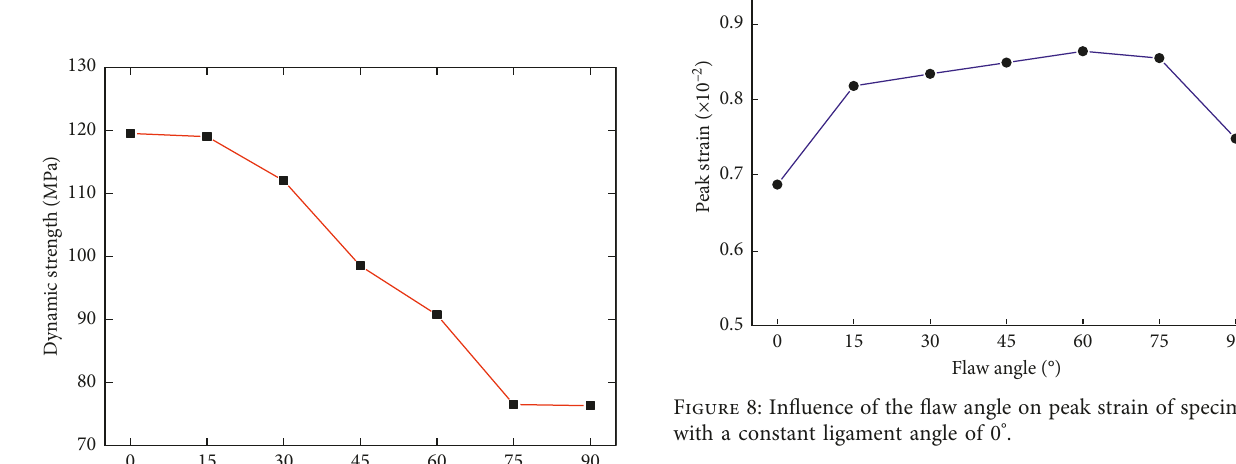
Figure 5: Influence of the flaw angle on the dynamic stress-strain curves of specimens with a constant ligament angle of 0 ° .